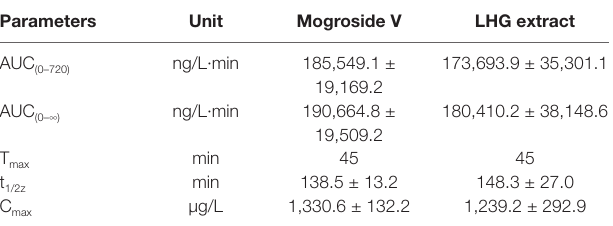
TABLE 5 | Pharmacokinetic parameters of mogroside V (200 mg/kg) and LHG extract (12.5 ml/kg) orally administered to rats (n = 6 per time point). Parameters